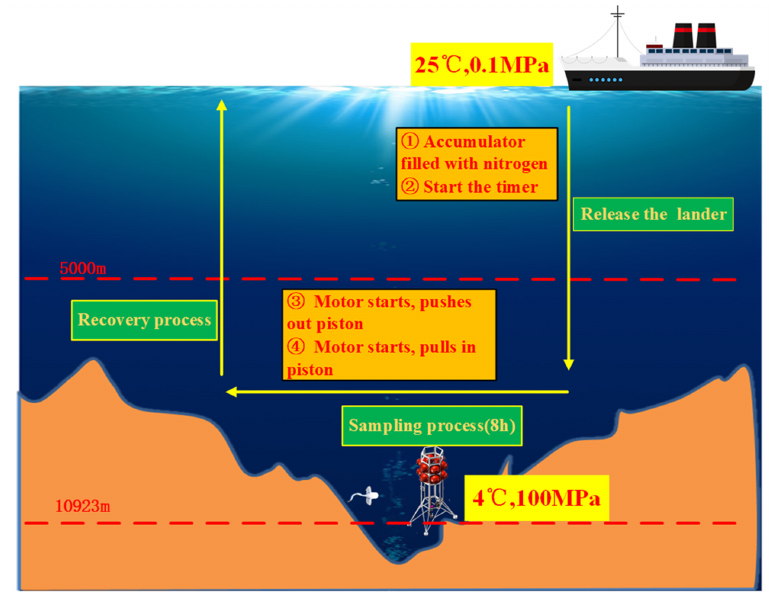
Figure 2. Work process of PMTI.